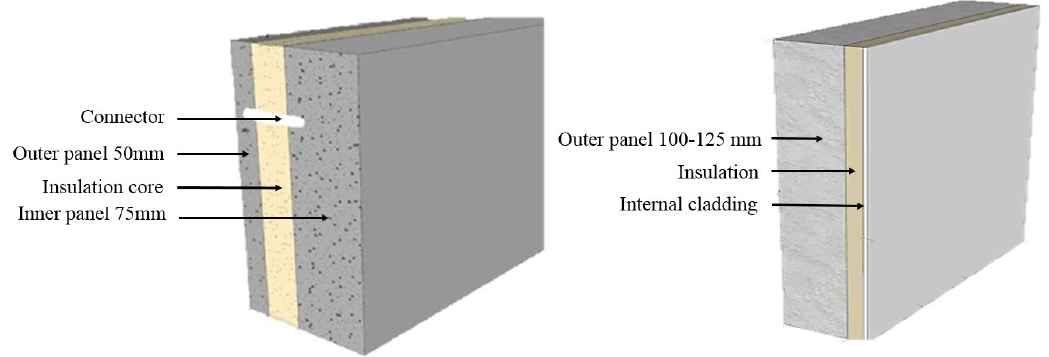
Figure 4. Insulated precast concrete panels (sandwich and single layer precast panel).